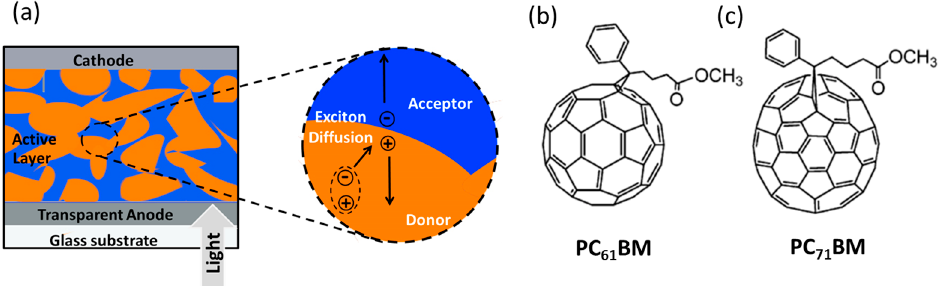
Figure 1. ( a ) Simplified schematic representation describing the main processes in a bulk-heterojunction solar cell device. The light absorption by the active layer (predominantly donor) generates excitons, which diffuses towards the donor-acceptor interface where they separate into free charge carriers (holes and electrons). Holes move towards anode and electrons move to the cathode. Chemical structures of fullerene-based acceptors ( b ) PC 61 BM and ( c ) PC 71 BM. fullerene-based acceptors ( b ) PC 61 BM and ( c ) PC 71